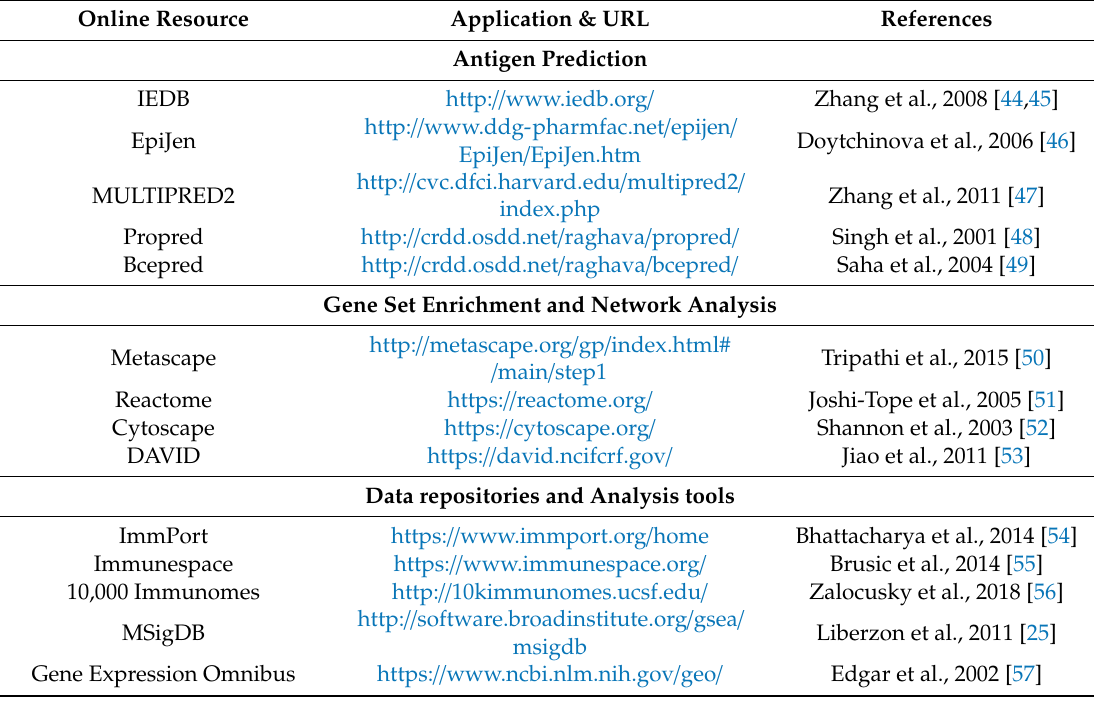
Table 1. Online resources for application in vaccine design and development. Online